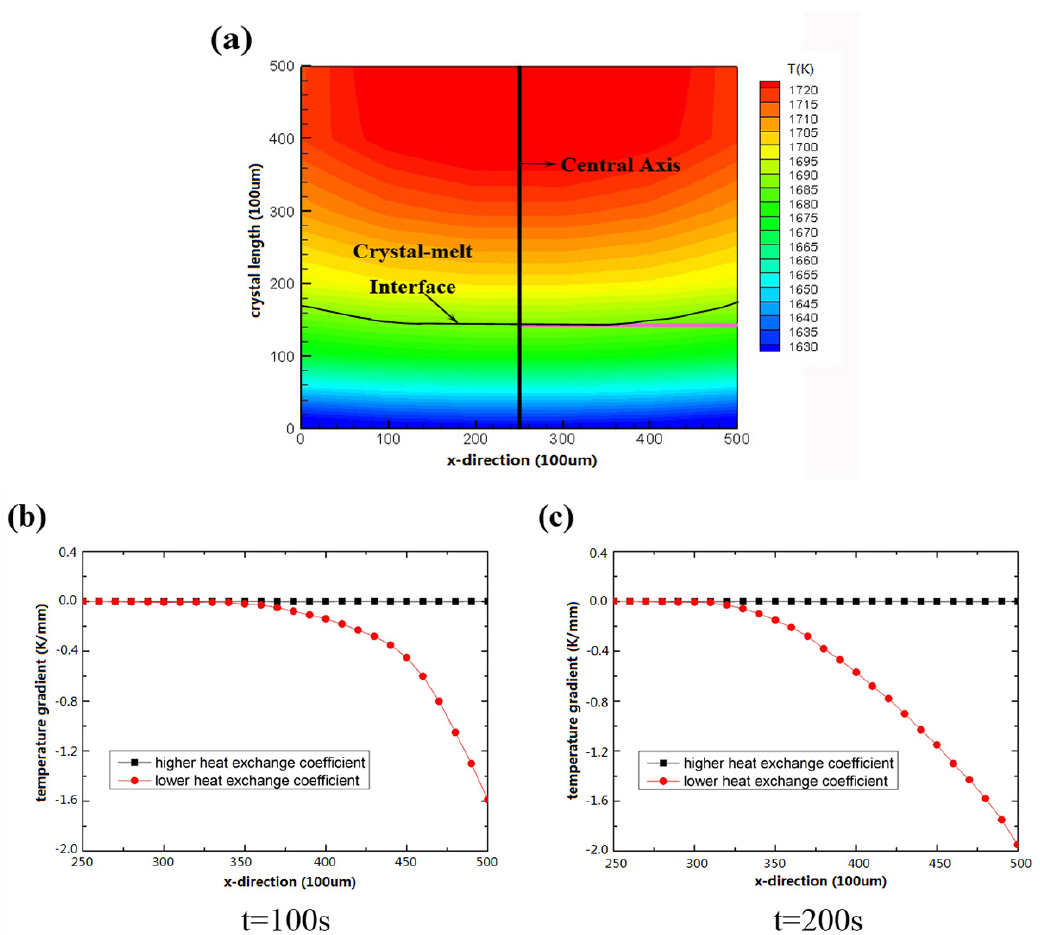
Figure 6. Distribution of temperature gradient in horizontal direction from central crystal-melt interface in different time with different heat transfer coefficient on the side boundaries: ( a ) marked x -direction of crystal-melt interface; ( b ) t = 100 s; ( c ) t = 200 s.